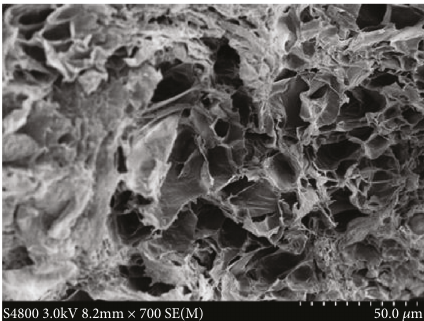
-based gel after 4